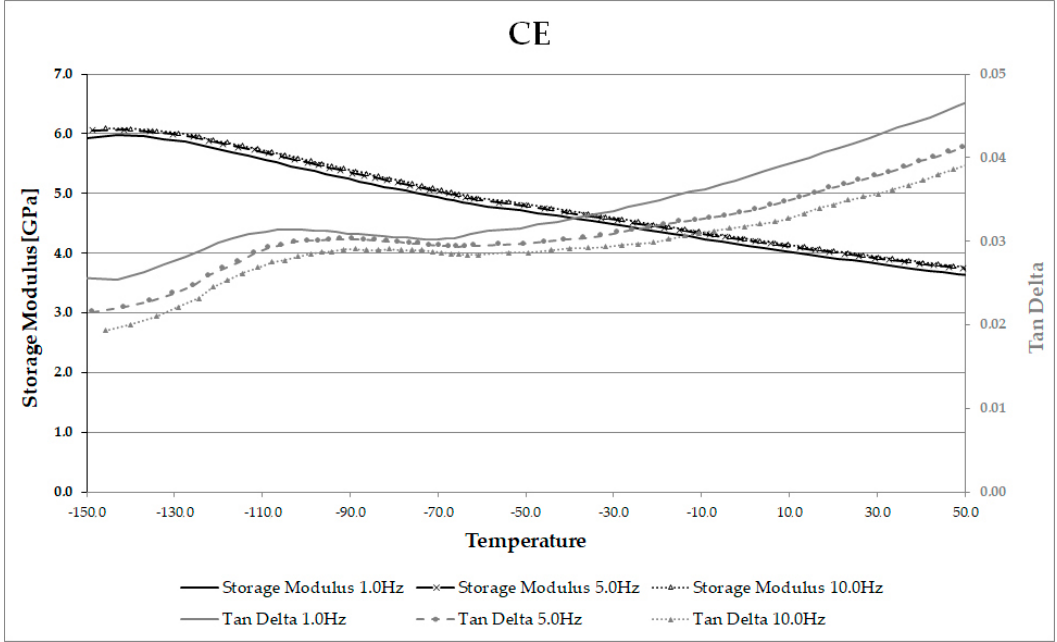
Figure 7. Multi-frequency scan of CE showing storage modulus and tan δ (note γ peak present at low temperatures).